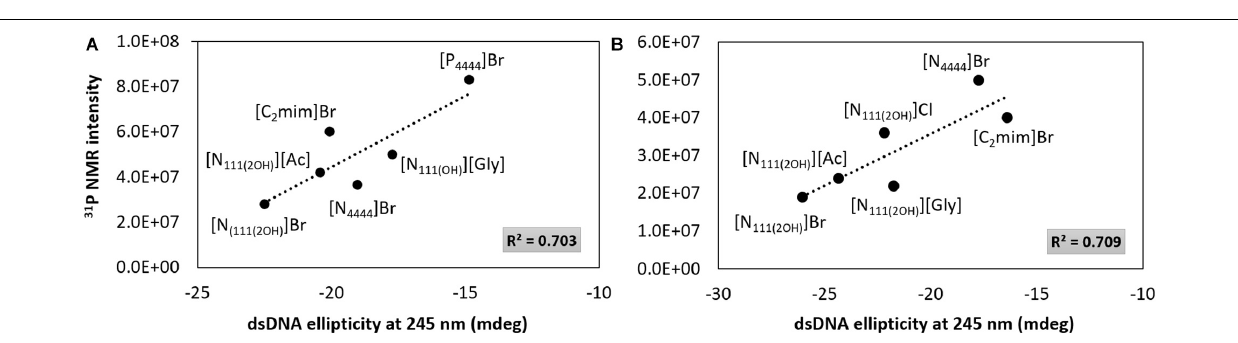
peaks of DNA. The higher the ellipticity of dsDNA, the higher the phosphorous peaks intensity of phosphate groups of